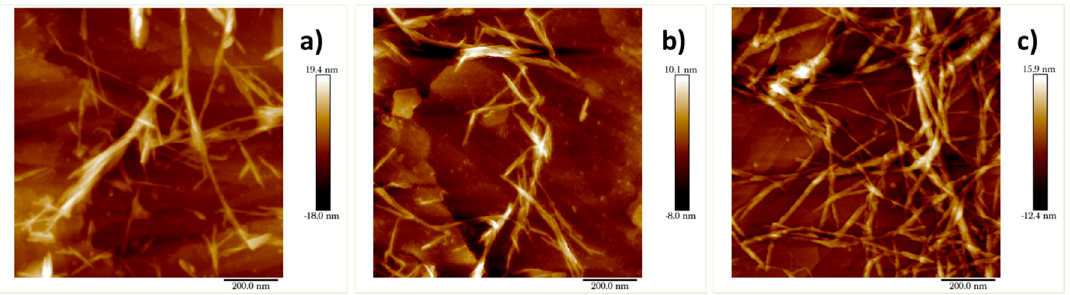
Figure 3. Atomic force microscopy (AFM) images of dispersions of ( a ) pulp-O; ( b ) pulp-O-Br; and ( c ) pulp after 15 passes through a homogenizer.